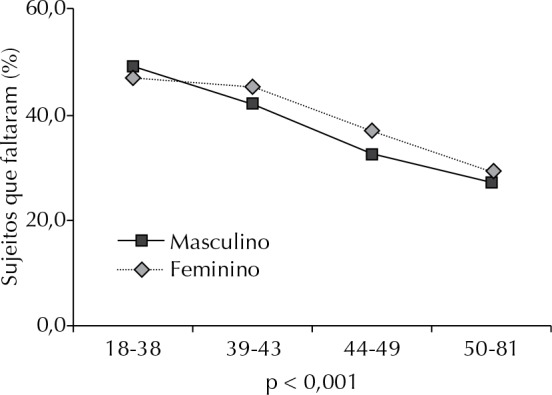
Proporção de pessoas com HIV que faltaram em consultas de infectologia, segundo sexo e idade.a,b SEAP HIV/aids, 2007.